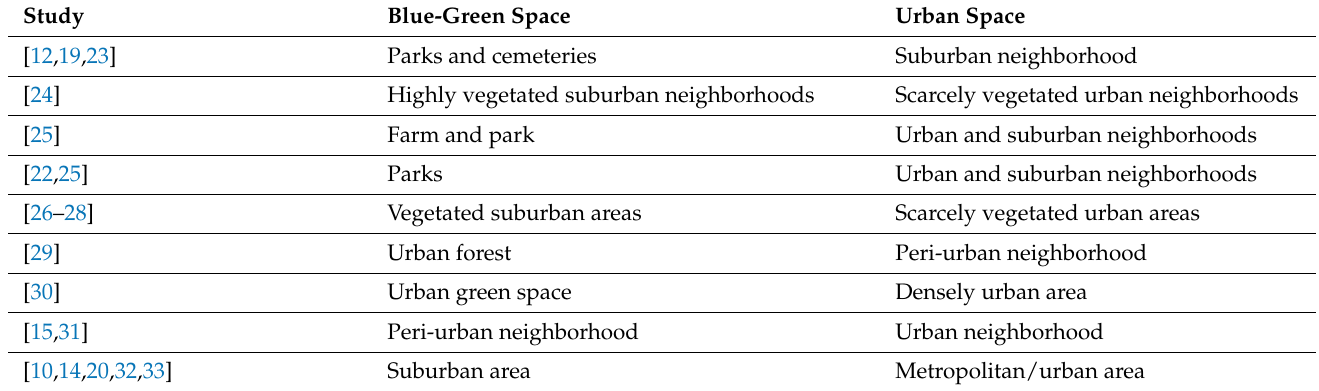
Table 1. Descriptions of blue-green space and urban spaces used for comparisons.